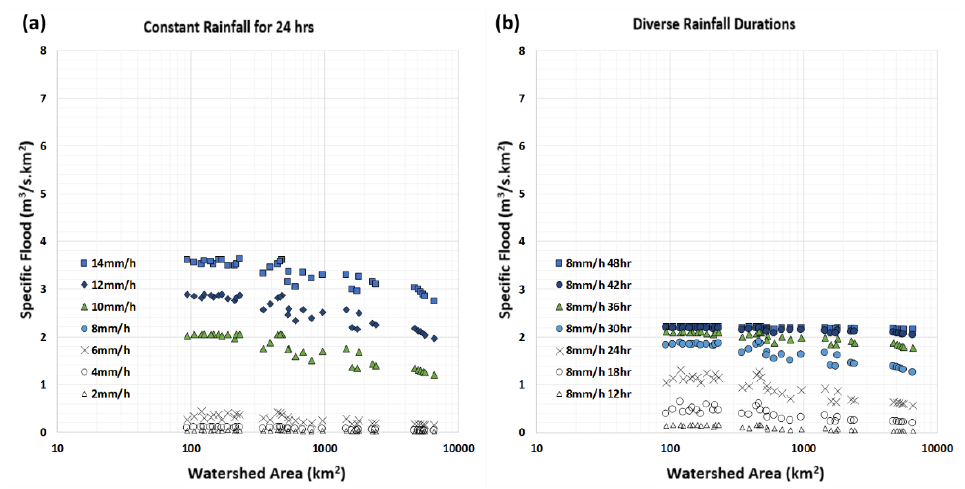
Figure 9. Minimum specific flood dependent on rainfall intensity and rainfall duration.